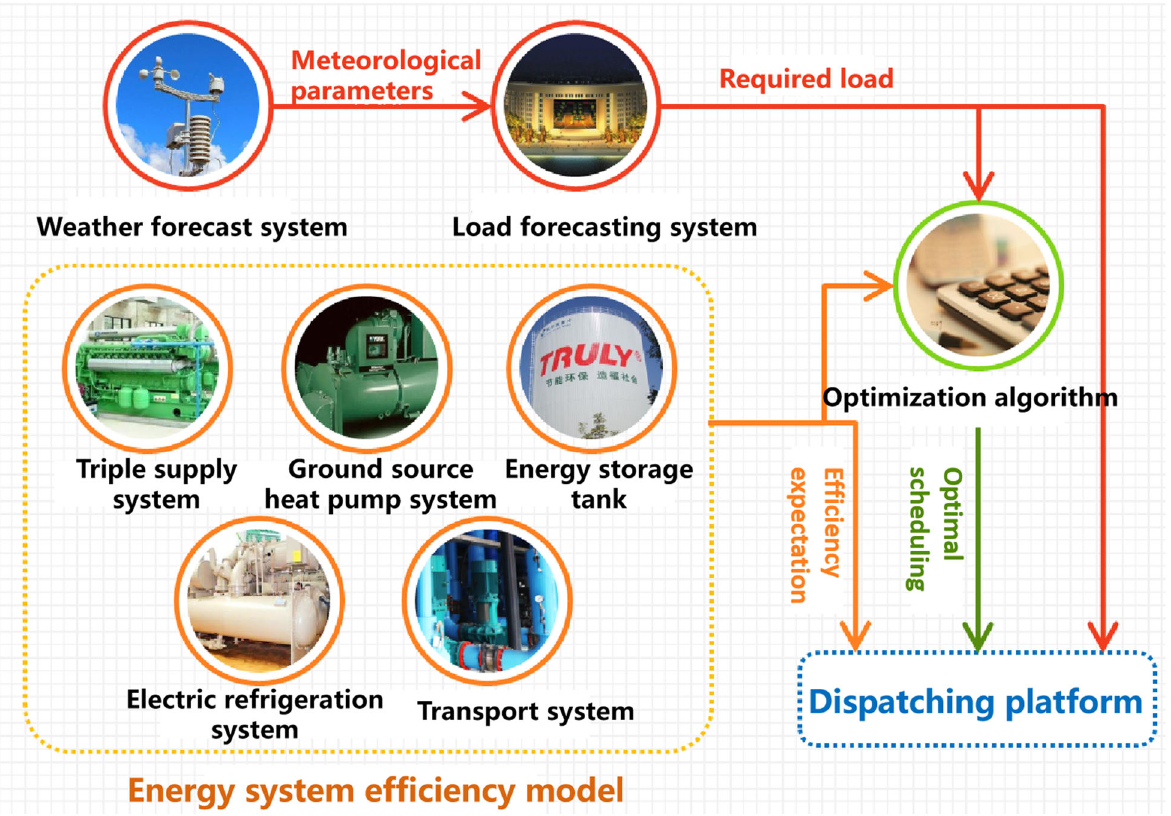
Fig. 28 Optimal operation scheduling platform of energy